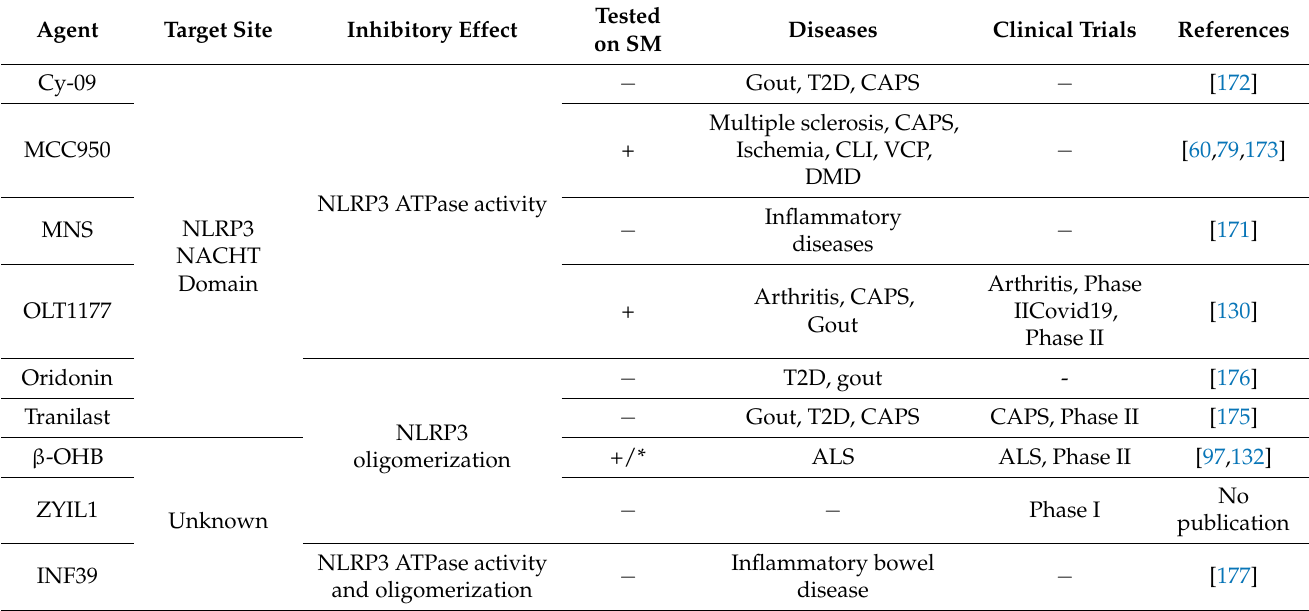
Table 1. Direct NLRP3 inhibitors, their mechanisms of action and involvement in